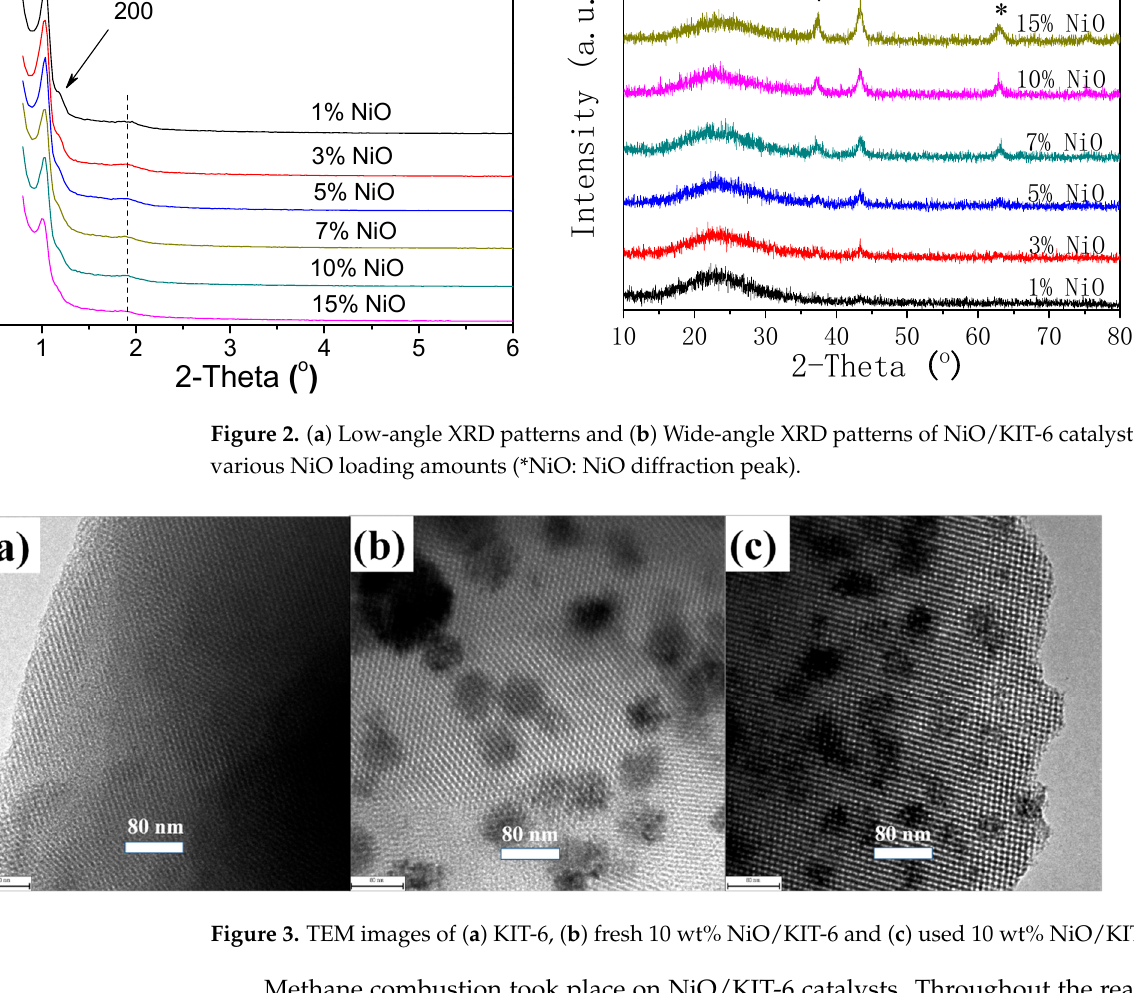
Figure 3. TEM images of ( a ) KIT-6, ( b ) fresh 10 wt% NiO/KIT-6 and ( c ) used 10 wt% NiO/KIT-6.